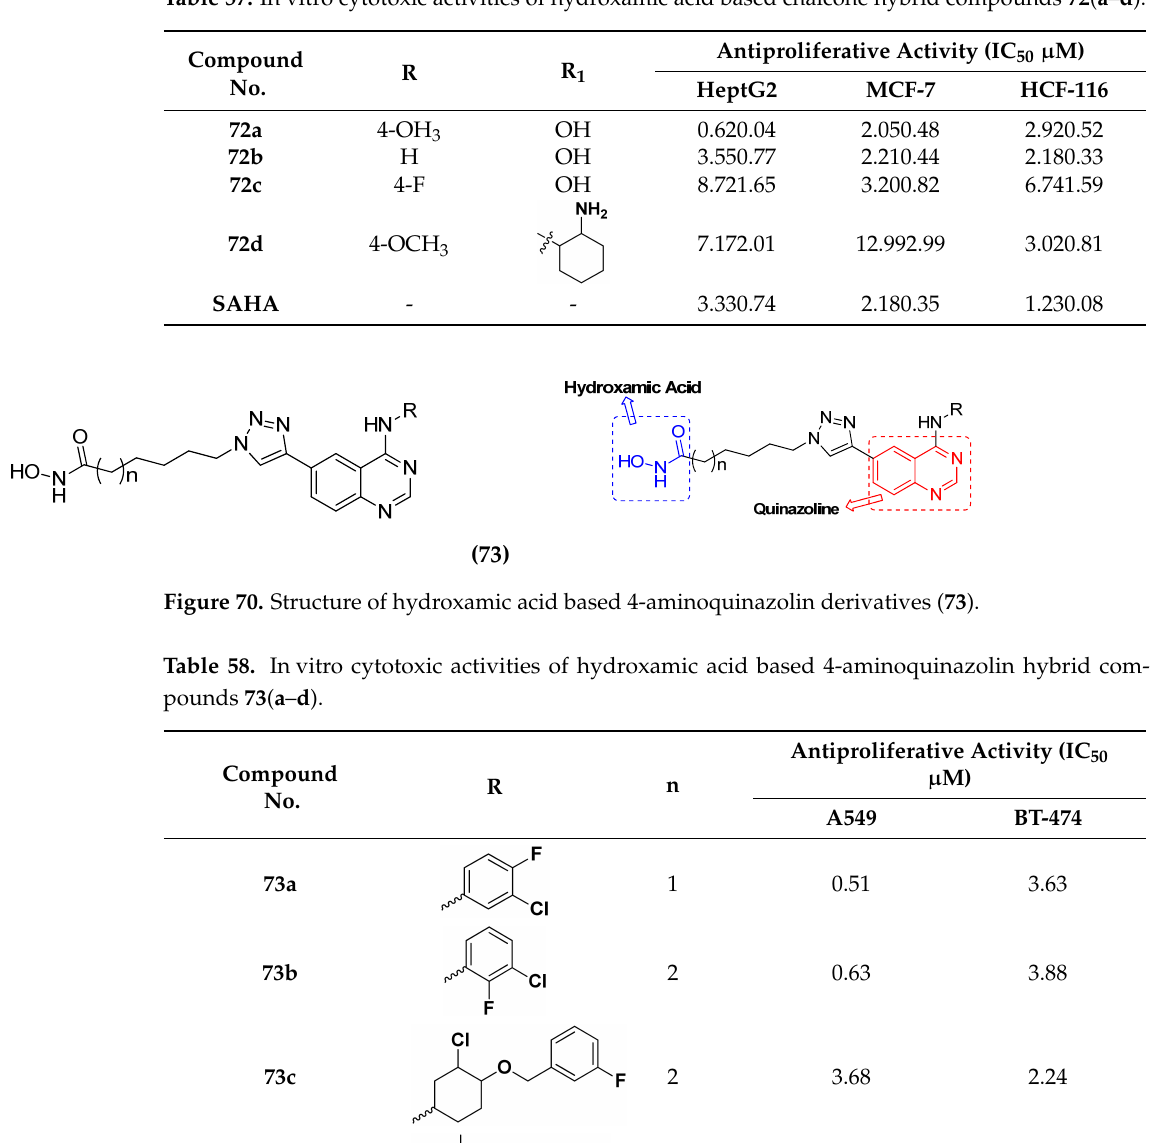
Table 57. In vitro cytotoxic activities of hydroxamic acid based chalcone hybrid compounds 72 ( a – d ).